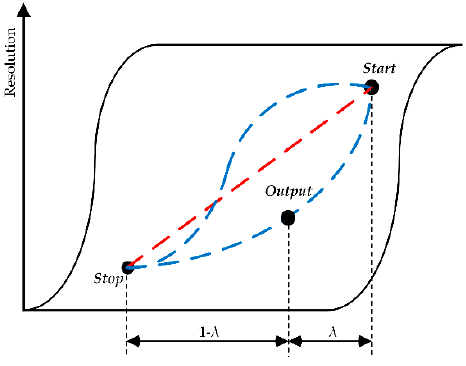
Figure 5. Illustration of resolution adjustment.